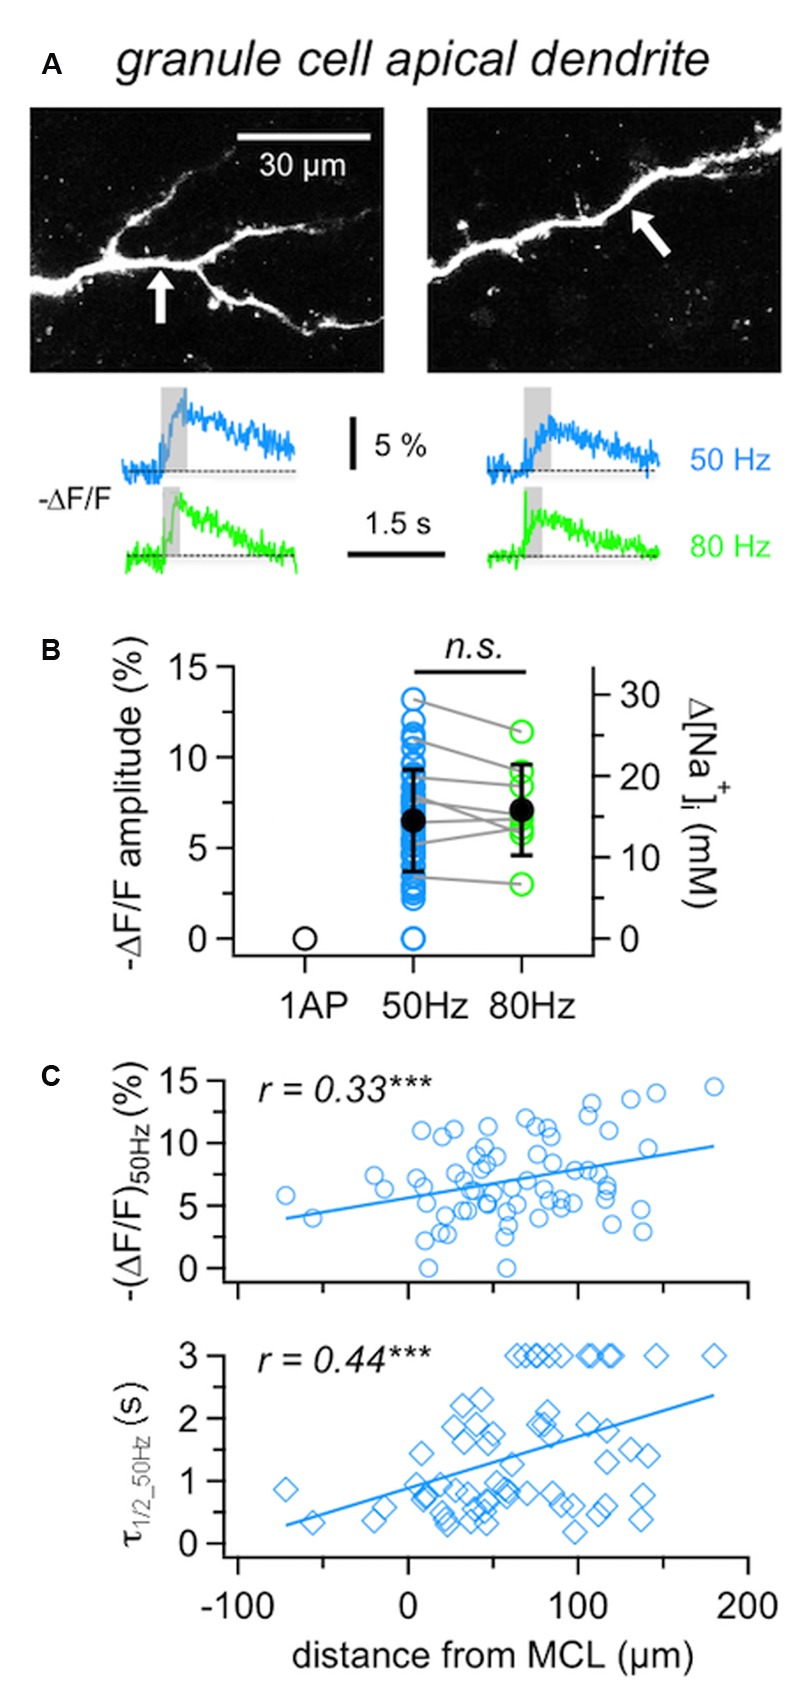
Na+ signals in GC apical dendrites. (A) Representative two-photon scans of apical dendritic segments from two GCs filled with 1 mM SBFI. The averaged fluorescence transients shown below were imaged at the locations indicated with white arrows. Train durations are indicated by the gray boxes. (B) Cumulative ΔF/F amplitude data for GC apical dendrites (n = 62 locations in 36 cells). Open symbols: individual data, solid black symbols: averaged data ± SD. Data where responses to both 50 and 80 Hz AP trains were recorded from the same location are indicated by gray connecting lines (n = 8 cells). (C) Cumulative data for responses to 50 Hz trains recorded from GC apical dendrites plotted versus the distance of the recording location from the lower border of the MC layer. Top panel: ΔF/F amplitude, bottom panel: ΔF/F half duration τ1/2. Lines: Linear fits of the data. Weak positive correlations were observed for both the amplitude and the half duration. ∗∗∗P < 0.005.